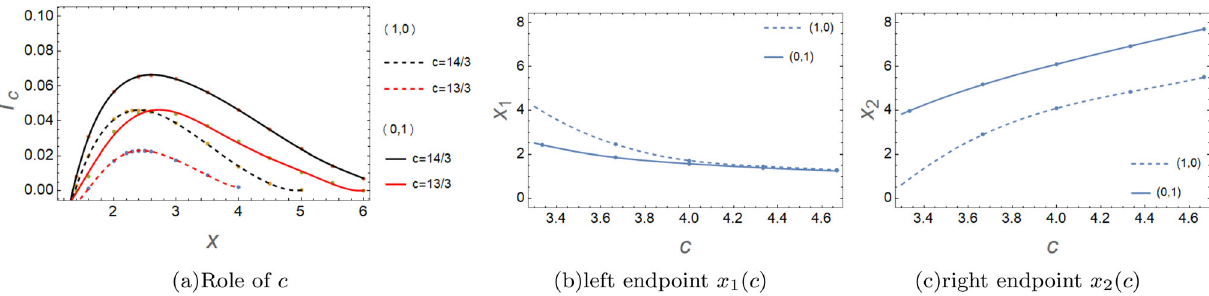
fix a = 10 , b = 4 / 3 ,α = 0 and choose different c . The dashed line represents ( 1 , 0 ) , and the solid line represents ( 0 , 1 )